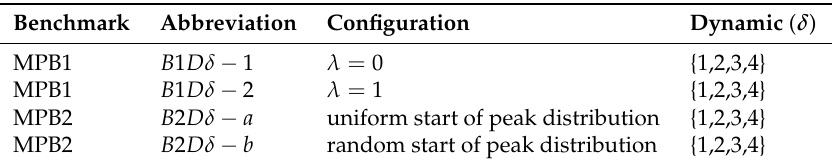
Table 2. Summary of problems.